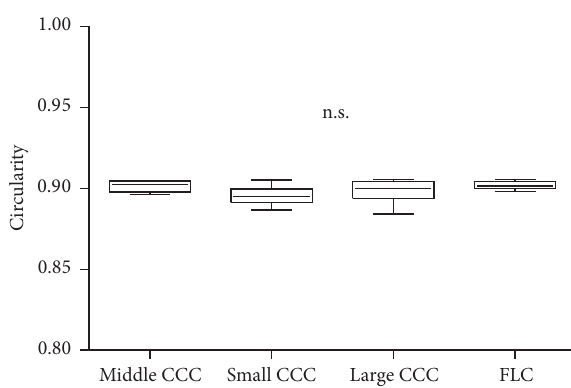
Figure 3: Comparison of capsule opening circularity among the FLC group and the small CCC, middle CCC, and large CCC subgroups. There were no significant differences among the groups. FLC: femtosecond laser capsulotomy; CCC: continuous curvilinear